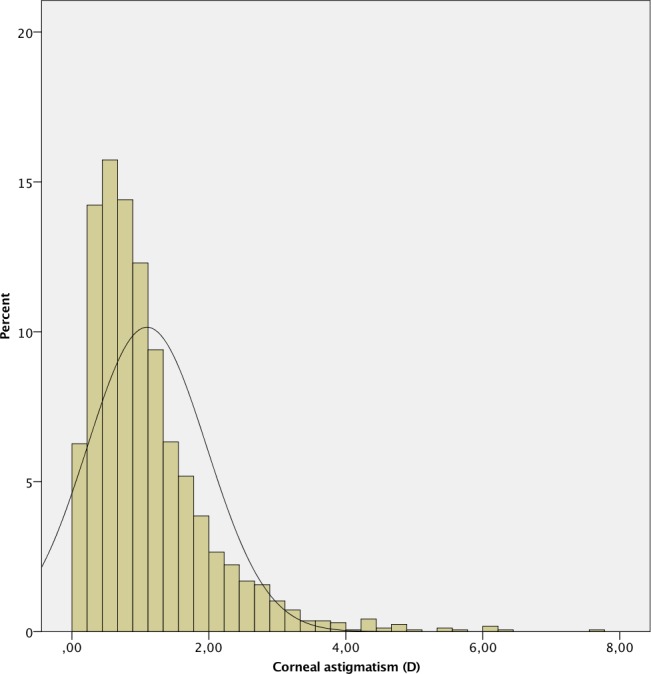
Histogram of corneal astigmatism of the study population.